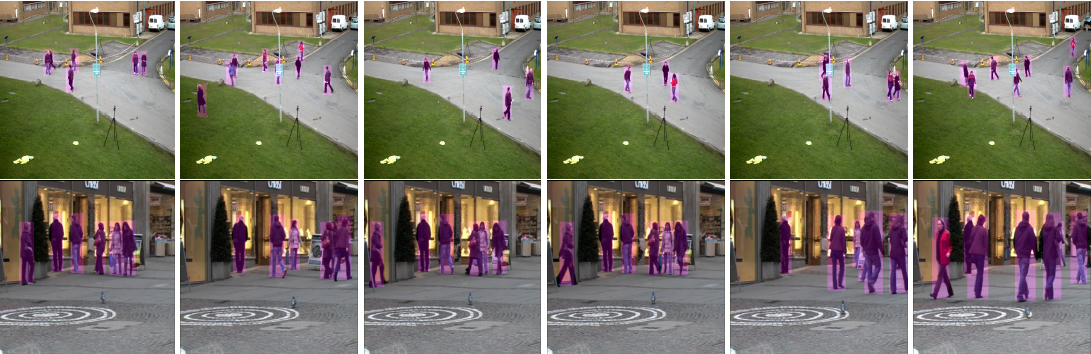
Figure 1. PedNet: proposed architecture. The input to the network is set of three frames at time instant t − 1, t , and t + 1. The network learned visual and temporal features and exploit it for spatial segmentation. The output is a binary mask which shows the region belonging to a pedestrian in the middle